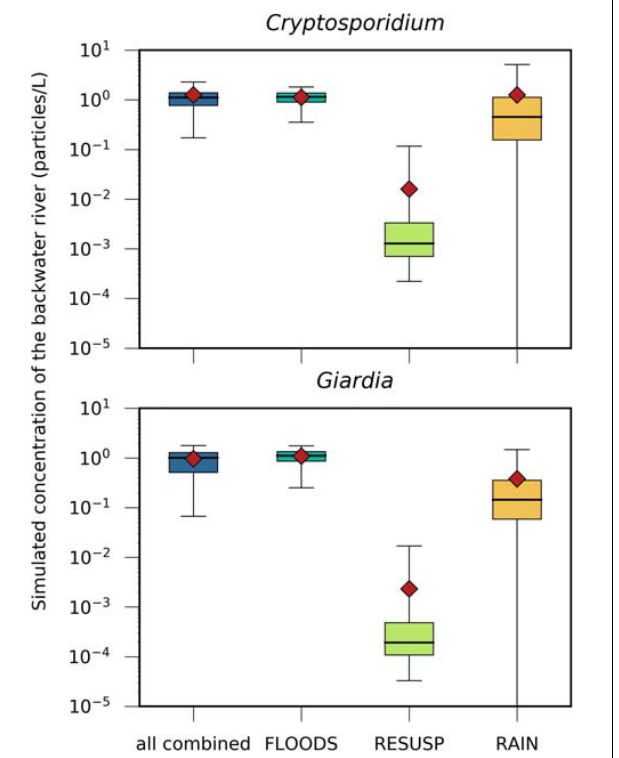
FIGURE 7 | Simulated concentrations of Cryptosporidium and Giardia , transported via (i) the discharge of Danube water (FLOODS), (ii) the resuspension of pathogens from fecal deposits in inundated areas (RESUSP), (iii) the rainfall-release and runoff from fecal deposits (RAIN), and all scenarios combined. Black horizontal lines, red diamonds, and whiskers mark the median, mean, and 95th percentile values,